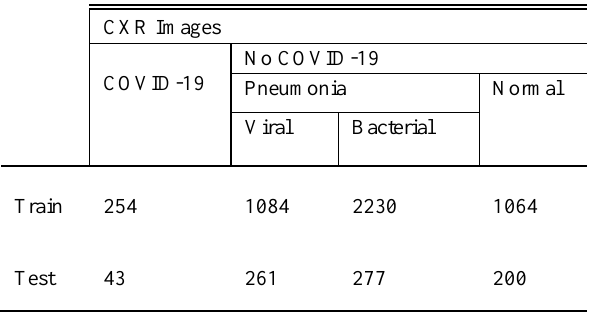
Table 2. The distribution of CXR images in training and test